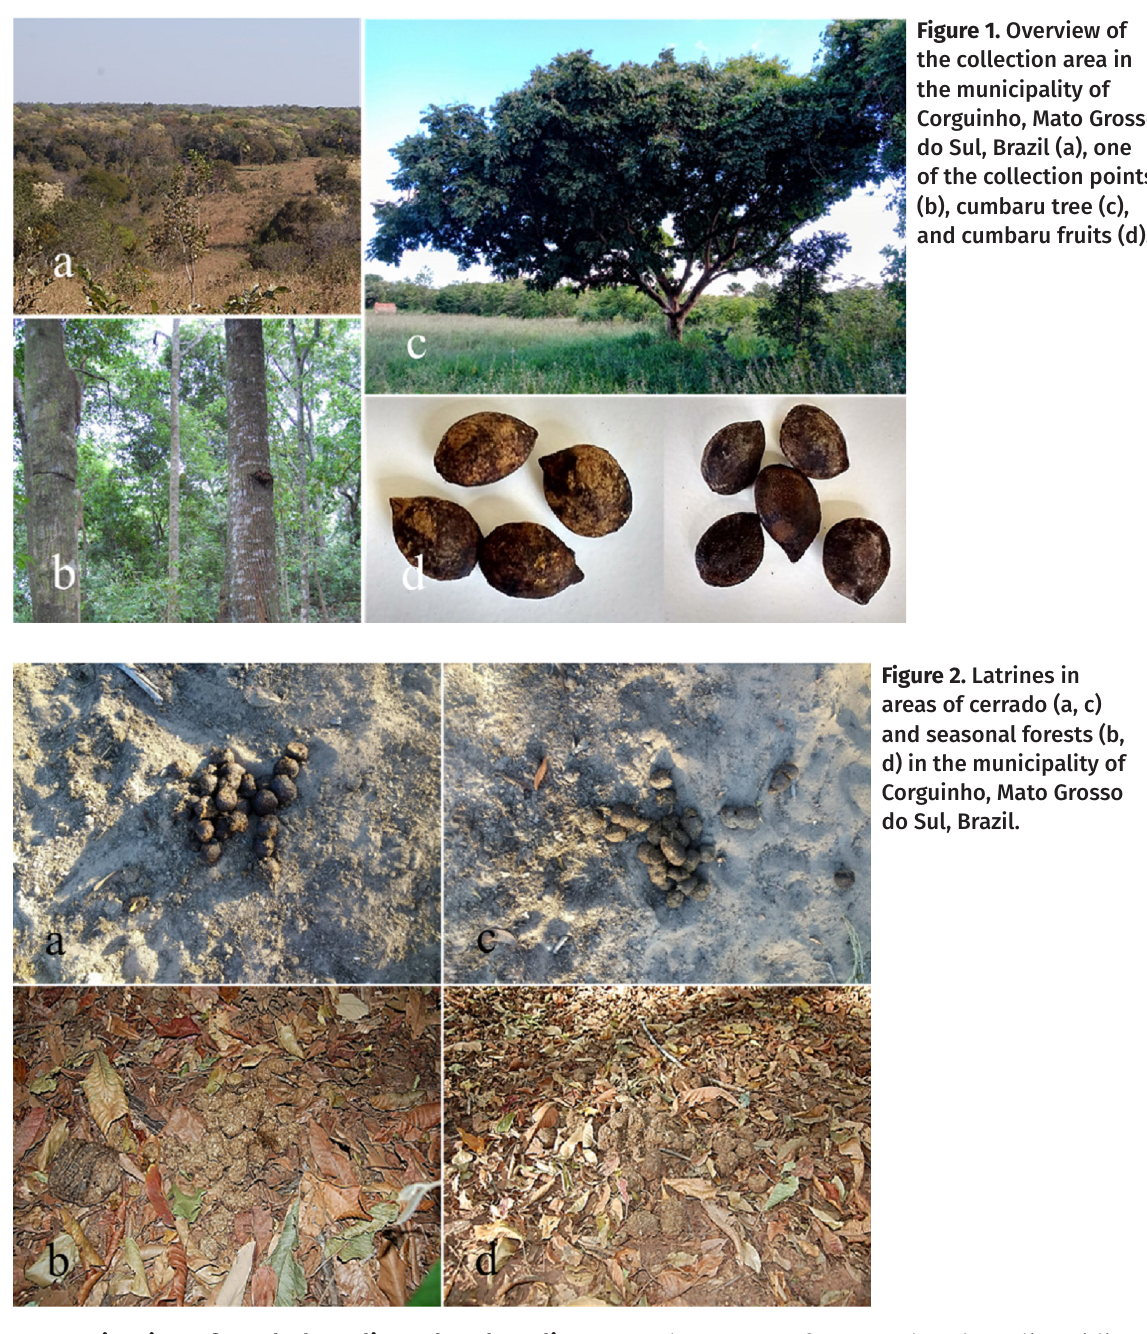
Figure 1. Overview of the collection area in the municipality of Corguinho, Mato Grosso do Sul, Brazil (a), one of the collection points (b), cumbaru tree (c), and cumbaru fruits